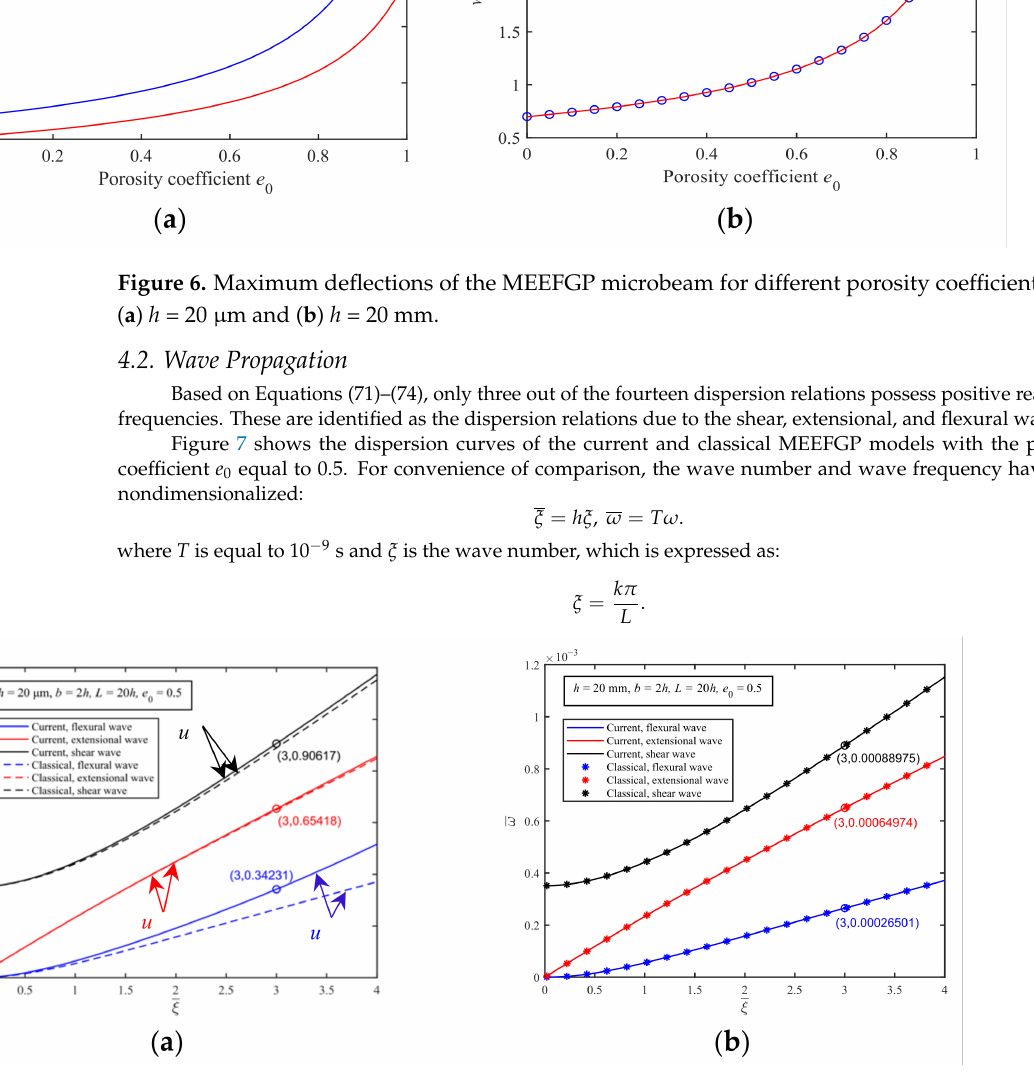
Figure 7. The dispersion curves due to the shear, extensional, and flexural waves for the current and classical MEEFGP models ( e 0 = 0.5) with thicknesses of ( a ) h = 20 µ m and ( b ) h = 20